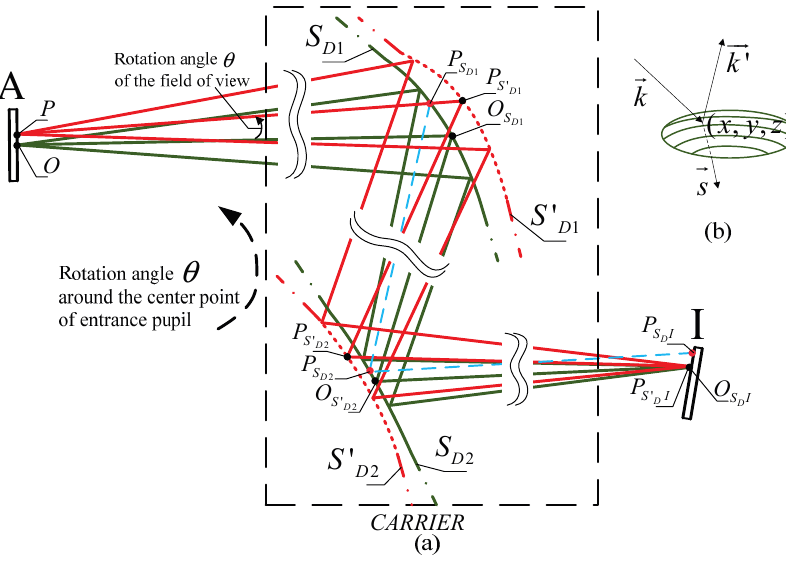
Figure 1. ( a ) Illustrates the ray tracing paths for image shift compensation using DMs. Double wavy lines in the optical system indicate optical elements on either side of the DMs. Green solid lines show the segments on the original profiles of DM surfaces S D and 1 S D placed between the object plane and the image plane. Red dotted lines show the 2 segments on the changed profiles of DM surfaces S’ D and S’ D for image shift 1 2 compensation. Green solid lines trace rays from point O , the initial location, through the optical system towards point O S . Points O S and O S are the intersections of the incident D I D 1 D 2 , P S and P S rays and the reflected rays on the DMs. The blue dashed lines from points P S D 1 D 2 D I represent ray tracing from the shift point location P in the initial optical path and locate a shift point P S on the image plane. Red solid lines are the rays from point P , the shift point D I using location on the object plane, tracing the compensated optical path towards point P S ’ D I the changed profiles of DM surfaces; ( b ) Illustrates the relationship between the vectors of the reflected rays and the normal line on one point of the mirror surface in